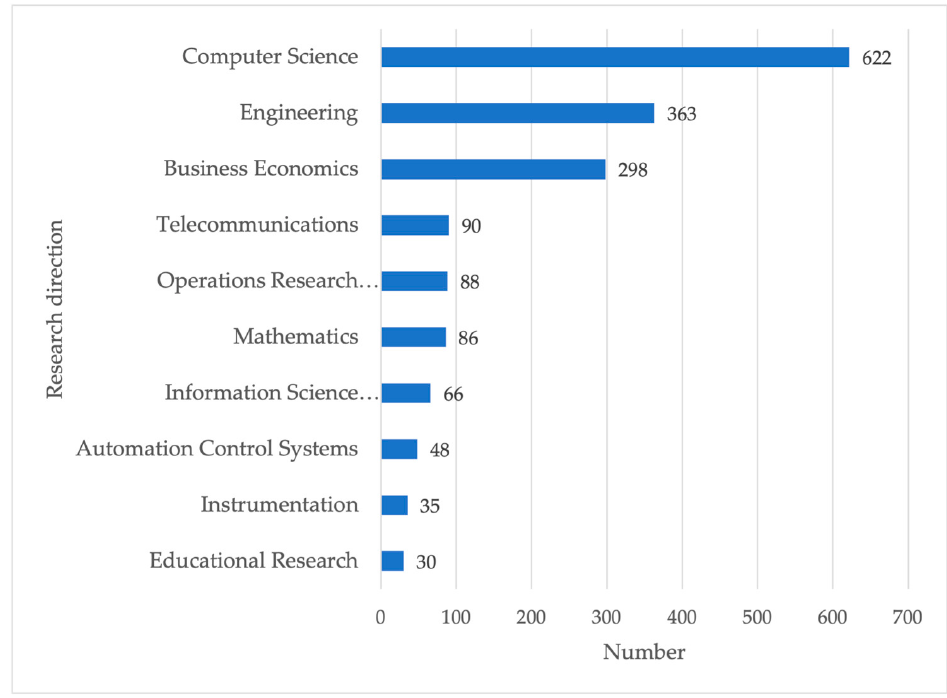
Figure 3. Distribution of the articles over research directions.